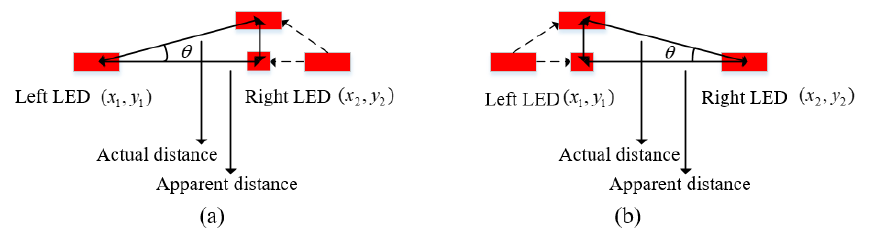
Figure 8. Hypothetical triangle for calculation of bending angle when the FWV turns ( a ) left and ( b )